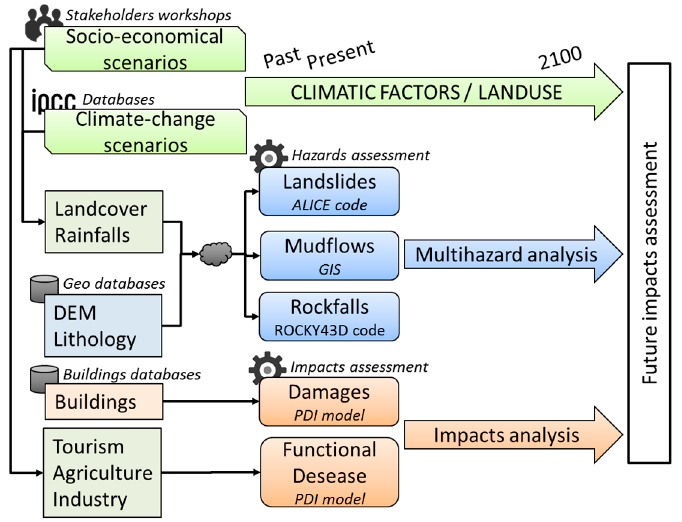
Figure 2. Illustration of the SAMCO methodology: Scenarios are first set up in order to assess the evolution of climate and economics in time. Parameters such as landcover, rainfalls, DEM, lithology, and stakes at risk are considered in different modelling tools to compute multi-hazards maps and impacts.